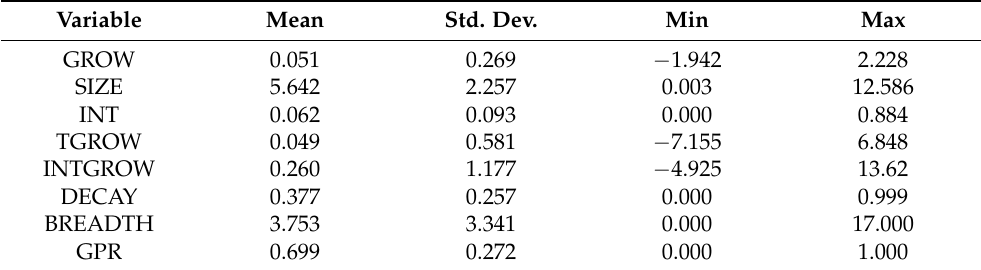
Table 5. Descriptive statistics.